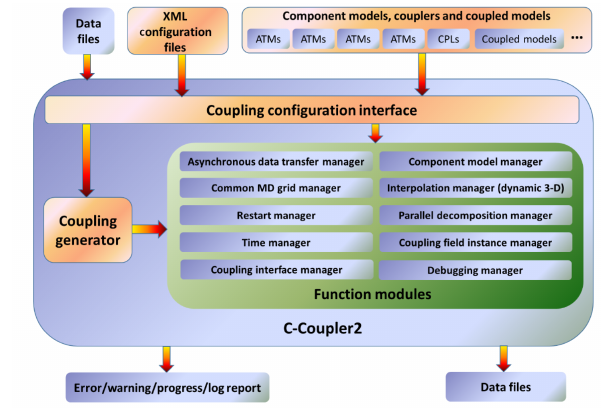
Figure 4. C-Coupler2 software